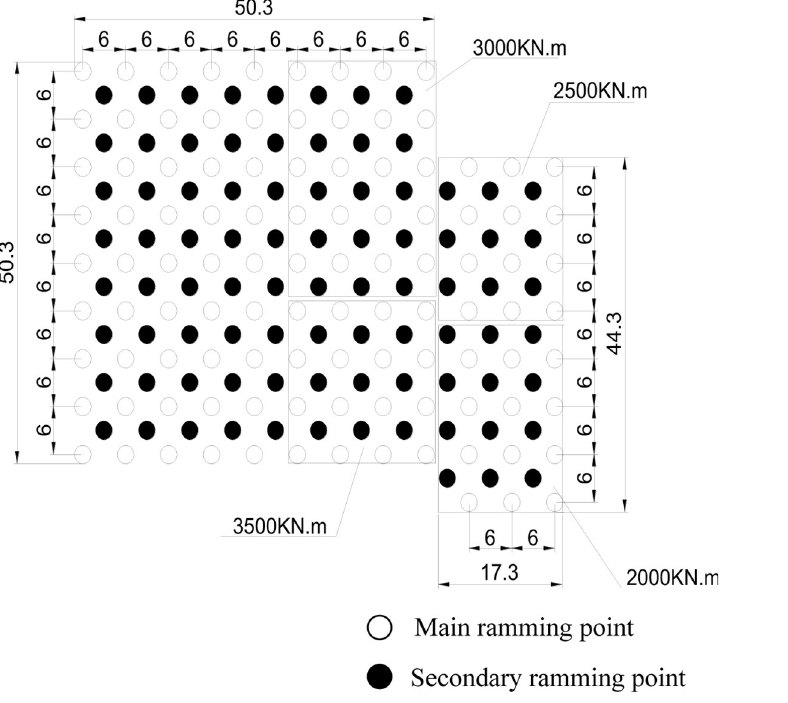
Fig 5. Layout of the ramming points in field